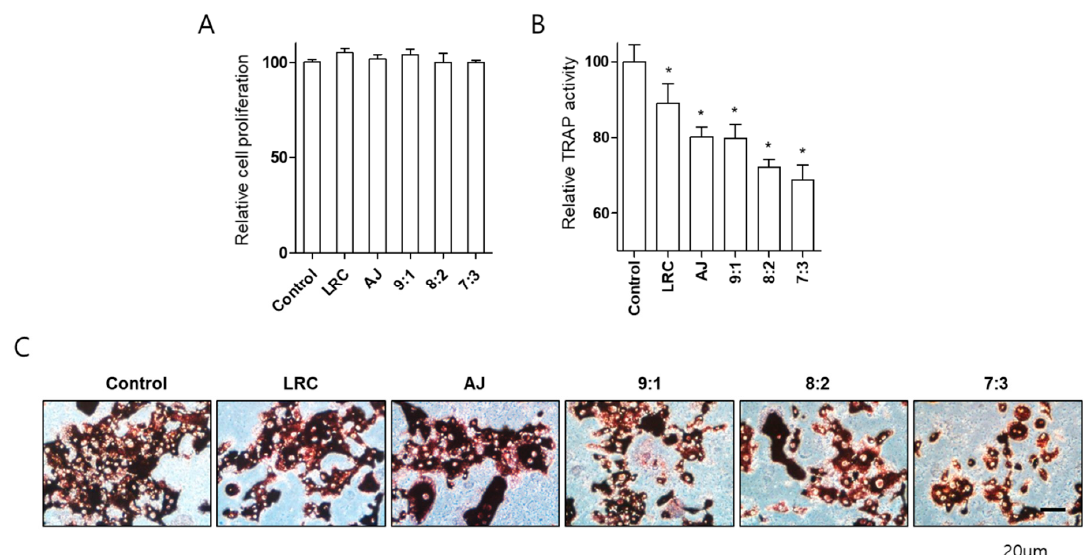
Figure 4. Effects of single or combined LRC and AJ extracts on cellular proliferation and differentiation of primary-cultured monocytes. Assessment were made of cell proliferation ( A ) and tartrate-resistant acid phosphatase (TRAP) activity in monocytes from mouse bone marrow ( B ). Osteoclast differentiation was induced by adding 30 ng/mL of M-CSF and 50 ng/mL of RANKL, and cells were treated with single or combined LRC and AJ (9:1, 8:2 or 7:3 ratio). The differentiated osteoclast cells were analyzed by TRAP activity ( B ) and TRAP staining ( C ). Control: Non-treated monocyte cells cultured with M-CSF and RANKL. *: p < 0.05 vs. Control.